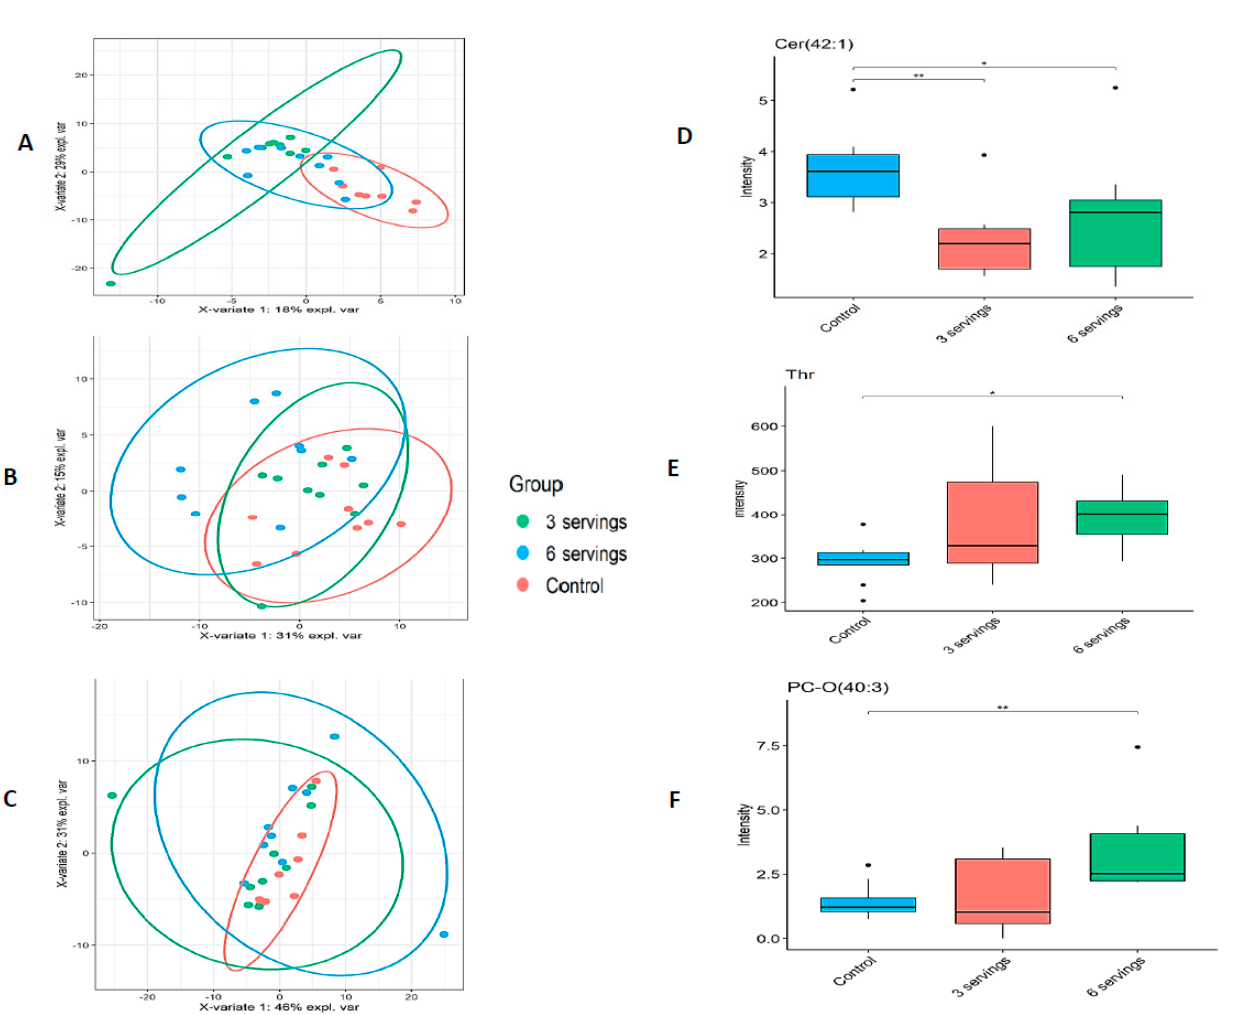
Figure 1. Partial least squares discriminant analyses (PLS-DA) among treatment groups in the liver and brain of pigs fed WBM-supplemented or control diets. PLS-DA plots showed separation of metabolites in the liver of pigs fed three servings of WBM-supplemented diet ( A ), the cortex of pigs fed six servings of WBM ( B ) and no significant separation in the hippocampus regardless of feeding WBM ( C ) ( p < 0.05) compared to pigs fed a control diet. Boxplot of top representative metabolite in liver: ceramide (Cer 42:1) ( D ), cortex: threonine (Thr) ( E ), and hippocampus: 1-alkyl,2-acylglycero-3-phosphocholine PC-O (40:3) ( F ) showing significant change in metabolite abundance after dietary treatment, * denotes p -value < 0.05, ** p -value < 0.01